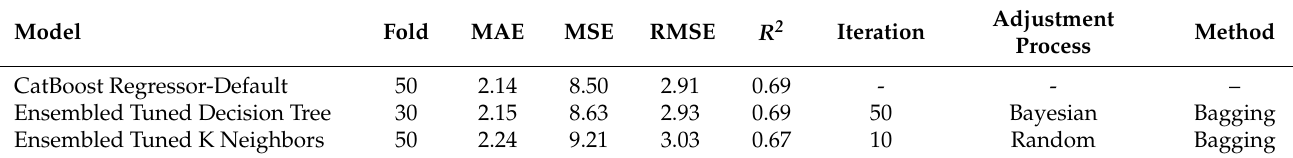
Table 6. Models selected to be combined in the Blend and Stack Ensemble Models process.